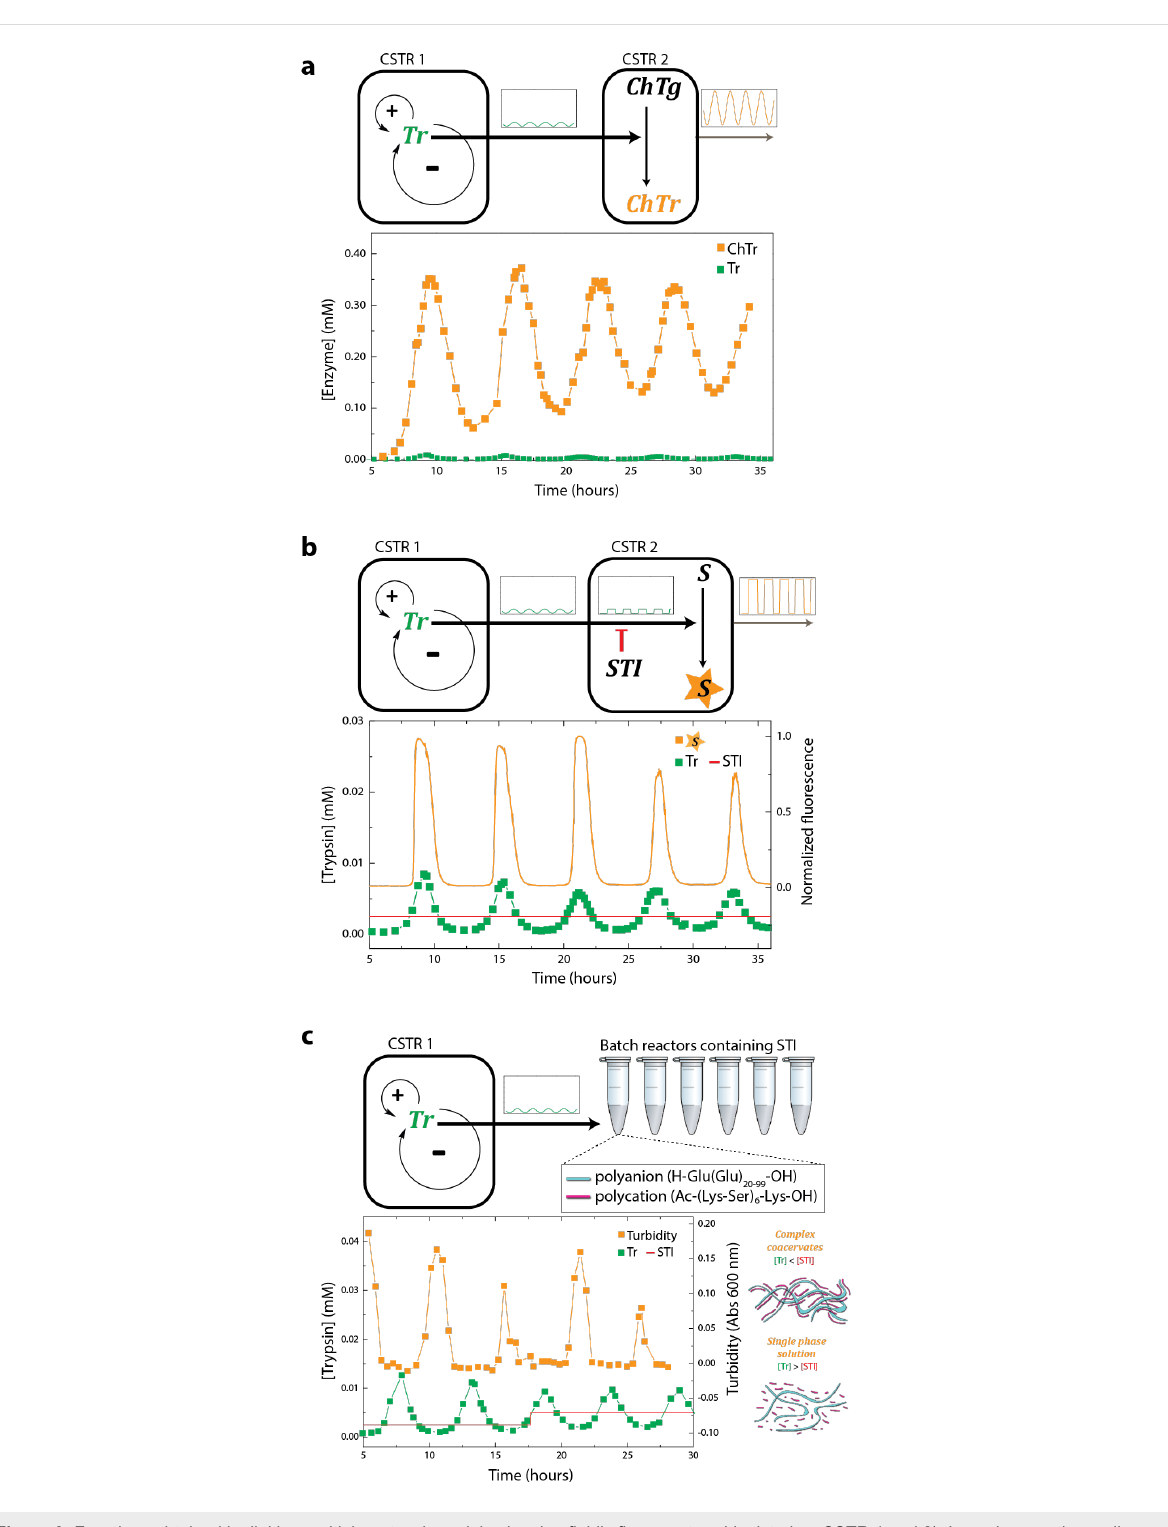
Figure 6: Functions obtained by linking multiple network modules in microfluidic flow reactors (depicted as CSTR 1 and 2). In each case, the oscil- lating catalyst concentration [Tr] from CSTR 1 is coupled to another CSTR that contains reagents producing (a) an amplification, (b) analog-to-digital conversion, or (c) a periodic control over equilibrium systems. The respective processes are: trypsin-catalyzed conversion of chymotrypsinogen (ChTg) to chymotrypsin (ChTr), trypsin-catalyzed conversion of a rhodamine substrate (S) to a fluorescent product (P) in the presence of a strong in- hibitor (soybean trypsin inhibitor, STI), and trypsin-catalyzed fragmentation of a polycation (in purple) in the presence of a polyanion (in cyan). Adapted with permission from [94], copyright 2015 Nature Publishing